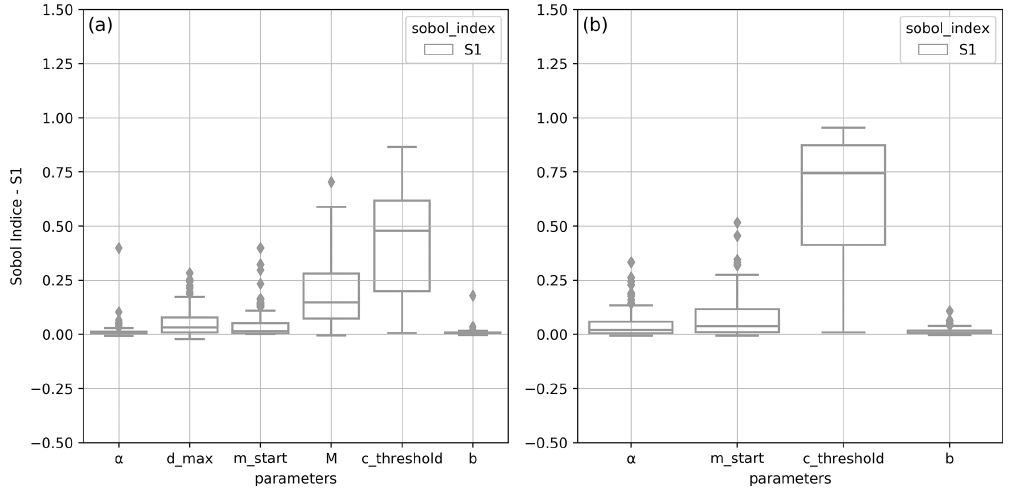
Figure 6. Distribution of first ( S 1)-order Sobol indices in the modeled reservoirs for each parameter: (a) in irrigation and (b) in non-irrigation